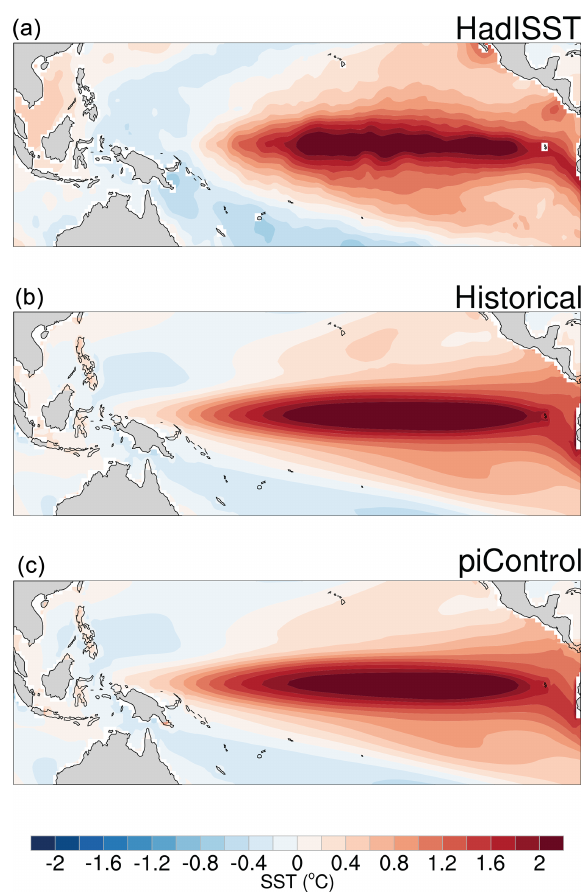
Figure 3. Evaluation of the ENSO SST anomaly pattern. Compos- ite El Niño minus La Niña sea surface temperature anomaly from (a) the HadISST observational dataset between 1871 and 2012, (b) model ensemble average from the historical simulations be- tween 1850 and 2005 (for CMIP5 models) or 1850 and 2015 (for CMIP6 models), and (c) model ensemble average from the pre- industrial control simulations. Units are ◦